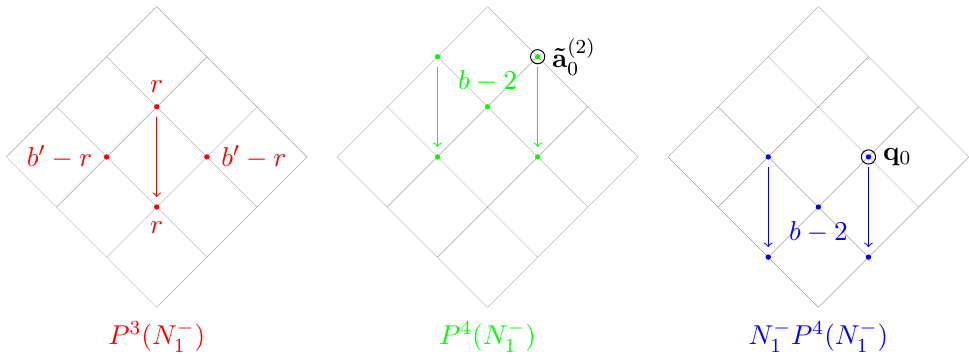
Figure 18 . The left picture shows a mixed Hodge structure, determined by some non-negative integer r , on P 3 ( N (cid:0) ). The middle picture shows a mixed Hodge structure on P 4 ( N (cid:0) ). The right 1 1 picture shows the image of the middle picture under the action of N (cid:0) . In these diamonds, the 1 coloured arrows label the action of N (cid:0) . The colourings are in agreement with equation (4.44) 2 (cid:0) (cid:1) and (cid:12)gure 14. The sum of these three Hodge-Deligne diamonds is the diamond of F ; W (2) , (2) associated to the mixed Hodge structure I p;q , of type III c . The circle around the dot in the last (2) diamond indicates the location of q 0 , and the circle around the dot in the middle diamond indicates the location of ~a (2) 0